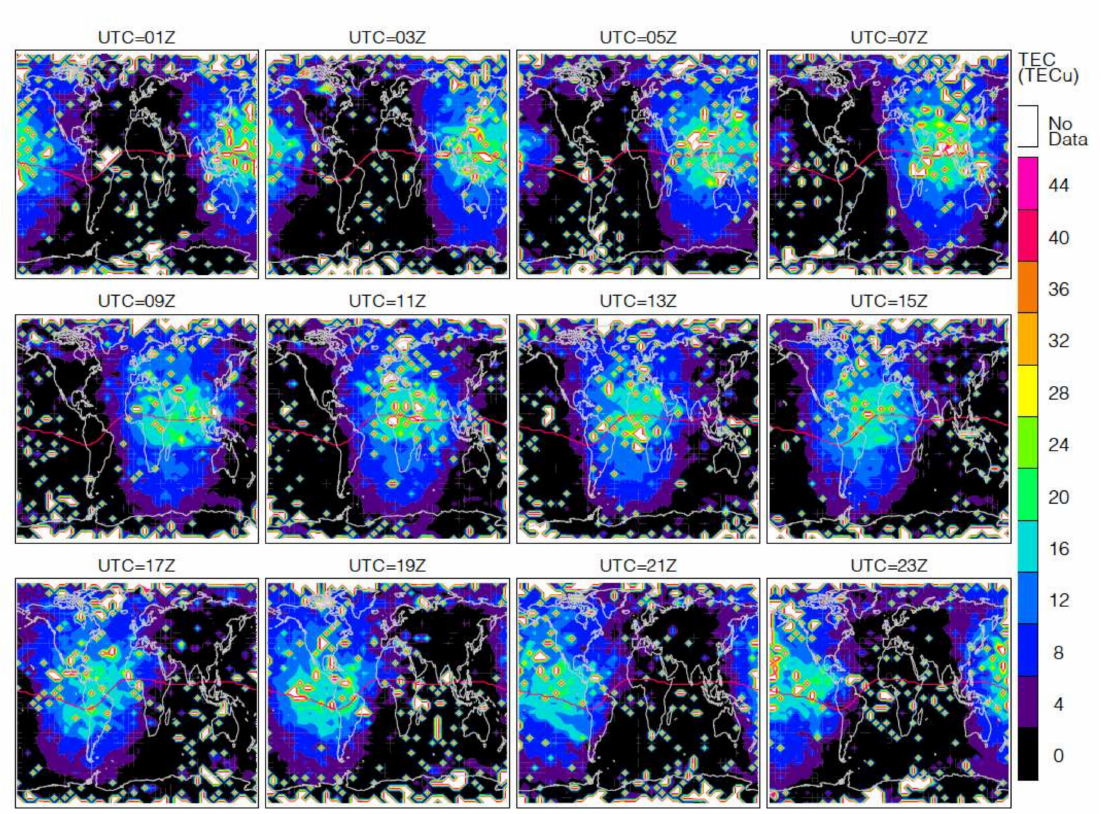
Figure 20. As in Figure 20, but for August 2008, observed by COSMIC-1, GRACE, TSX, and